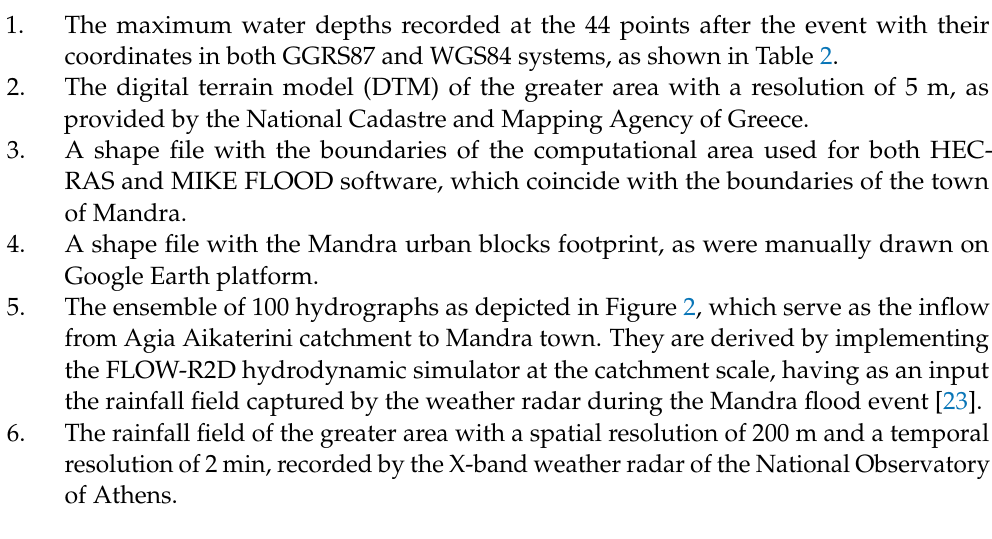
Table 2. Maximum water depths measured at the